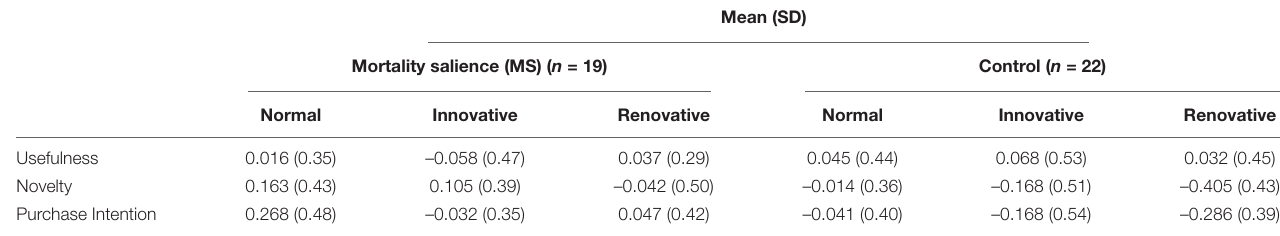
TABLE 3 | The results of ANOVA of Experiment